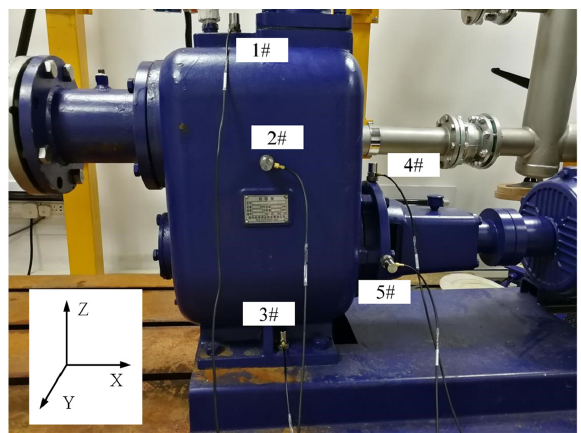
Table 3. Technical information of acceleration sensors.